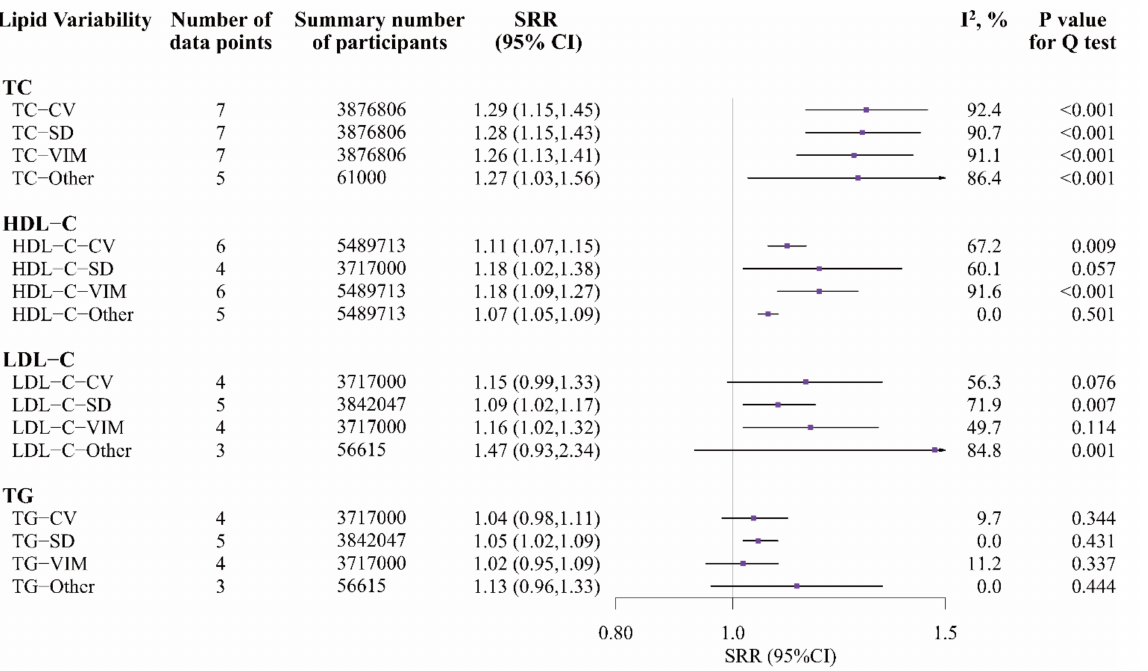
Figure 2. Random-effects meta-analysis of standardized RRs for different types and metrics of LV (top vs. bottom quartile) and CVDs. Notes: If data were reported based on subgroups of CVDs, they were treated as different data points; LV, lipid variability; CVDs, cardiovascular diseases; TC, total cholesterol; HDL-C, high-density lipoprotein cholesterol; LDL-C, low-density lipoprotein cholesterol; TG, triglycerides; CV, coefficient of variation; SD, standard deviation; VIM, variation independent of the mean; TC-Other included average real variability of TC (TC-ARV), standard deviation of the residuals of TC (TC-SDR), and root mean square error of TC (TC-RMSE); HDL-C-Other included average real variability of HDL-C (HDL-C-ARV); LDL-C-Other included average real variability of LDL-C (LDL-C-ARV); TG-Other included average real variability of TG (TG-ARV).